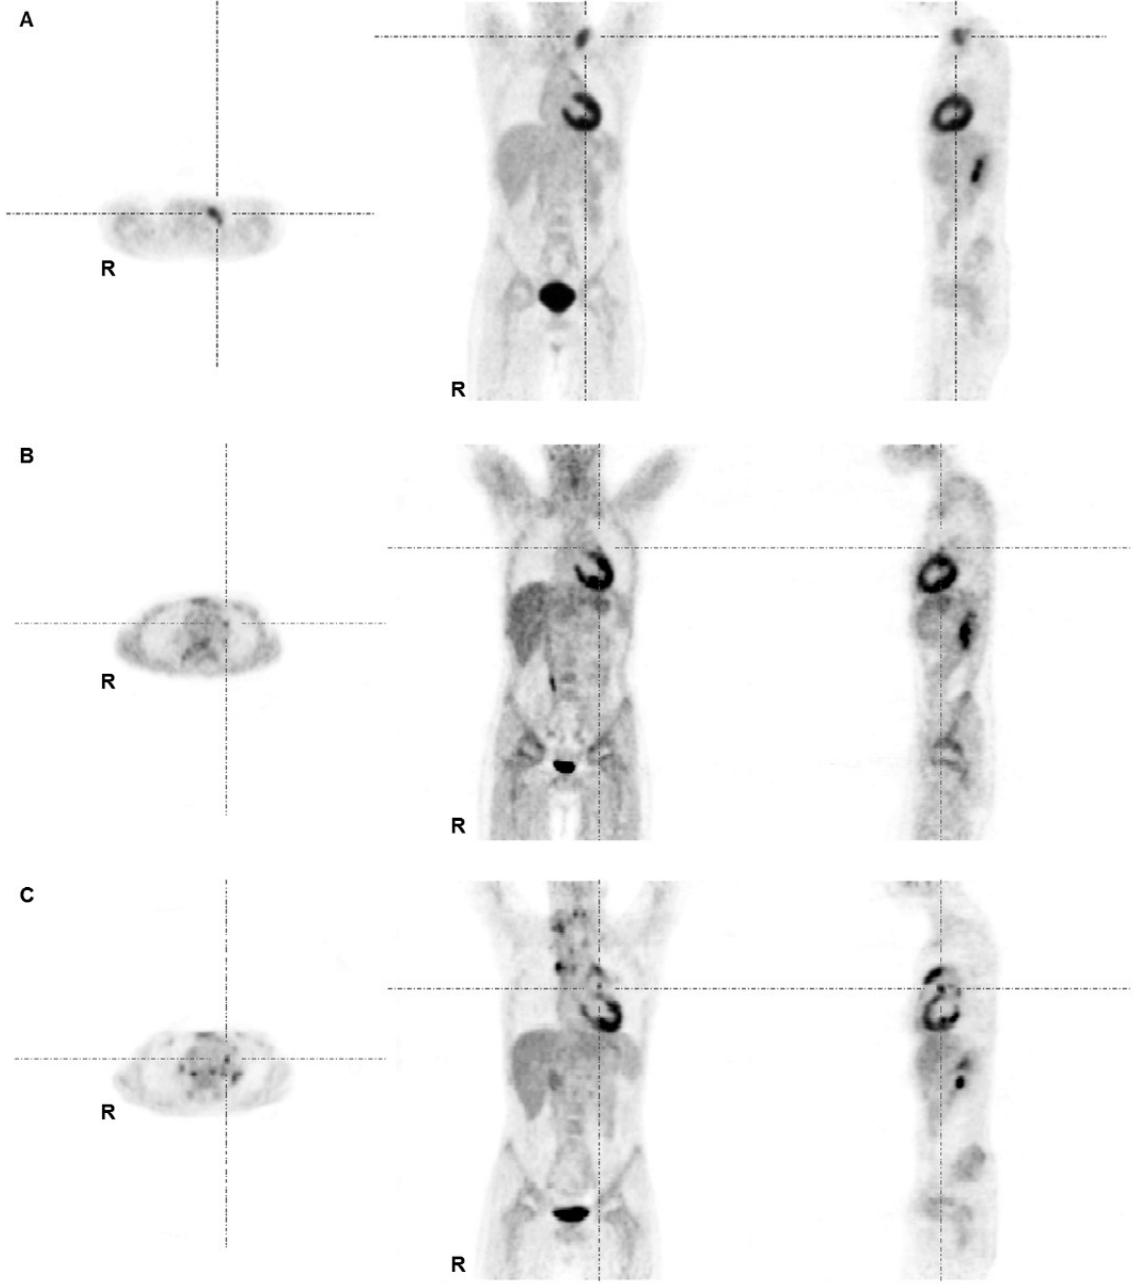
Figure 1. FDG-PET images of an 11-year-old male patient with mixed cellularity HL stage II at staging ( A ), interim ( B ) and at restaging due to suspected relapse 16 months after initial diagnosis ( C ). ( A ) Lymphoma lesions at staging were found at left supra- and infraclavicular sites and in the mediastinum. The patient was treated according to the TG1 protocol (GPOH-HD2002P); ( B ) The interim PET demonstrated minimal residual uptake in the left mediastinum adjacent to the left atrium/ventricle primarily interpreted as physiological myocardial uptake (with no anatomical equivalent in the corresponding low-dose CT). This lesion was missed by the first truth-panel assessment (false negative by visual assessment). By semi-quantitative means the lesion exceeded SUV thresholds (true positive by semi-quantitative means); ( C ) PET at time point of restaging showed multiple areas of intense tracer uptake indicating a